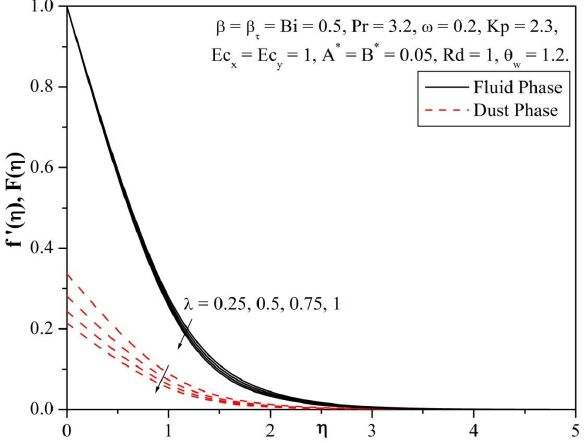
Fig. 6: Dimensionless profiles of v , v p velocity components for different values of λ .